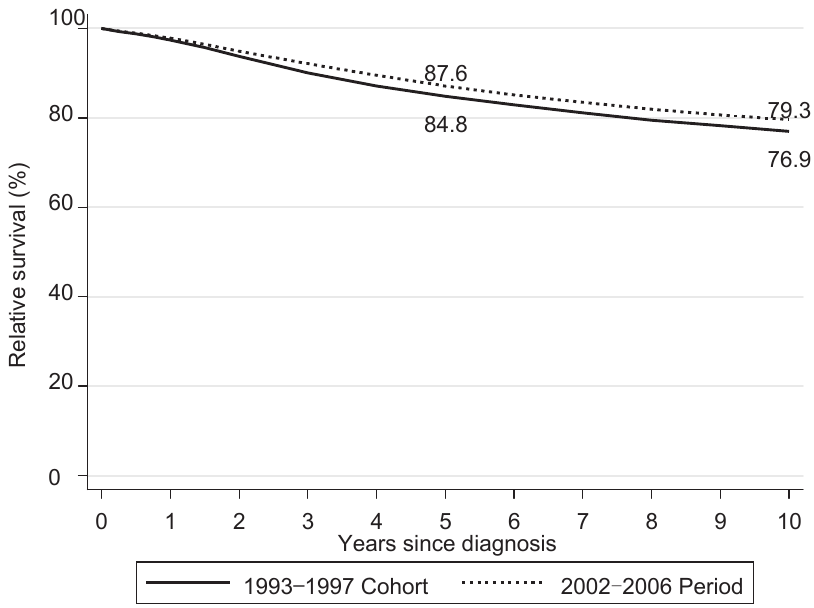
Figure 2. Relative survival of patients with breast cancer by period